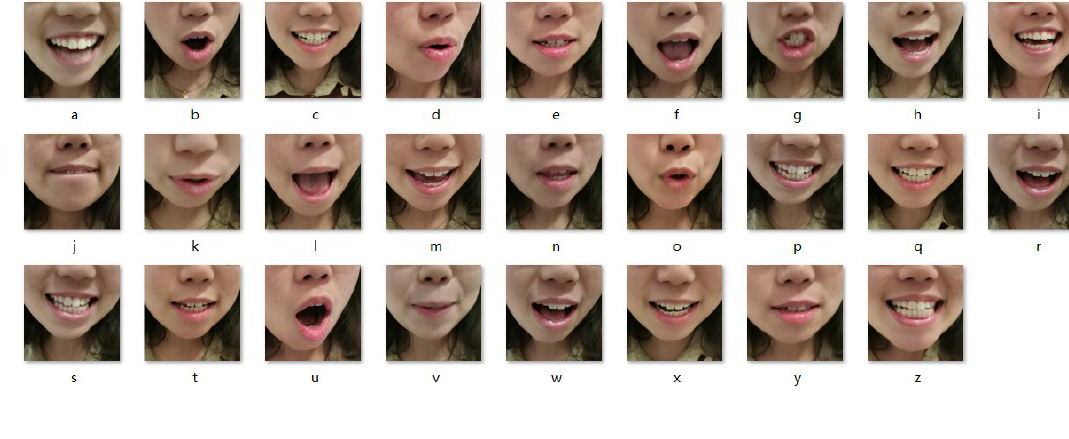
Figure 1. Collected lip language